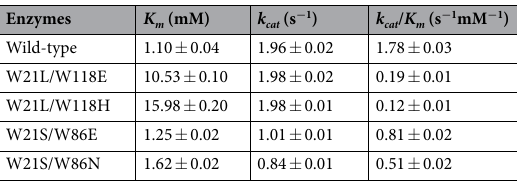
Table 3. Kinetic parameters of the Tm1743 double mutants.